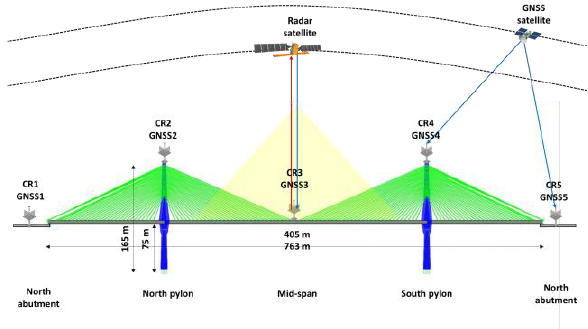
Figure 1. GNSS and PsInSAR monitoring system installed on the cable stayed bridge